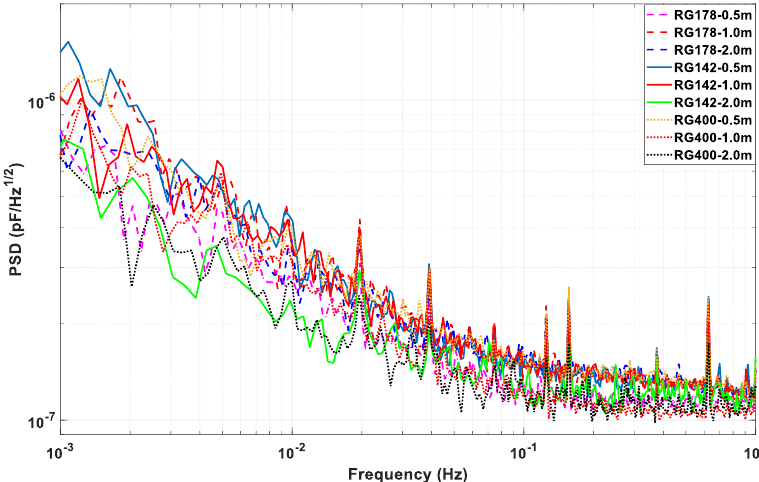
Figure 9. Noise level of the capacitive position sensor under all nine circumstances.